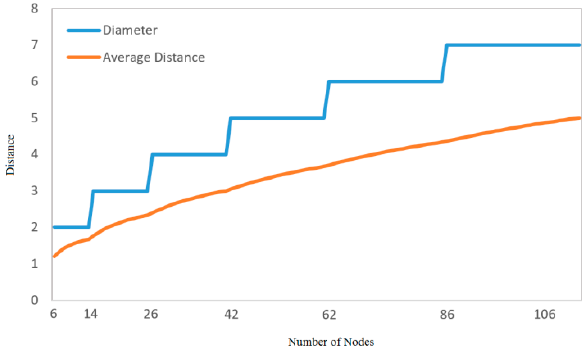
Figure 15. Diameter and average distance of the dual